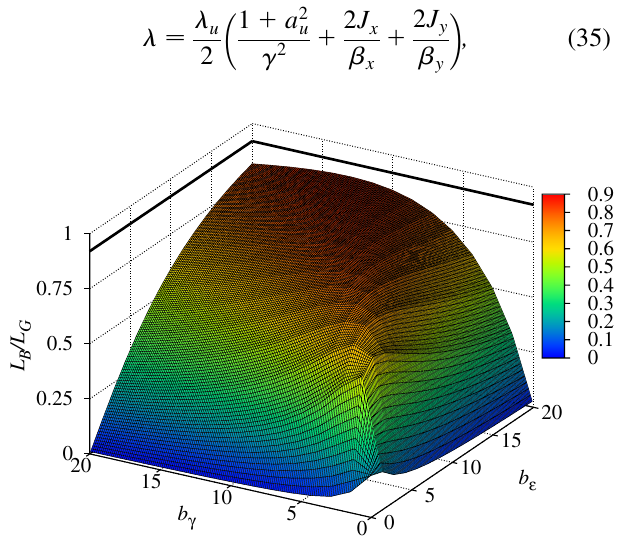
FIG. 3. (Color) Growth rate for fixed brightness as a function of energy spread and emittance parameters. The effect of diffrac- tion is assumed to be